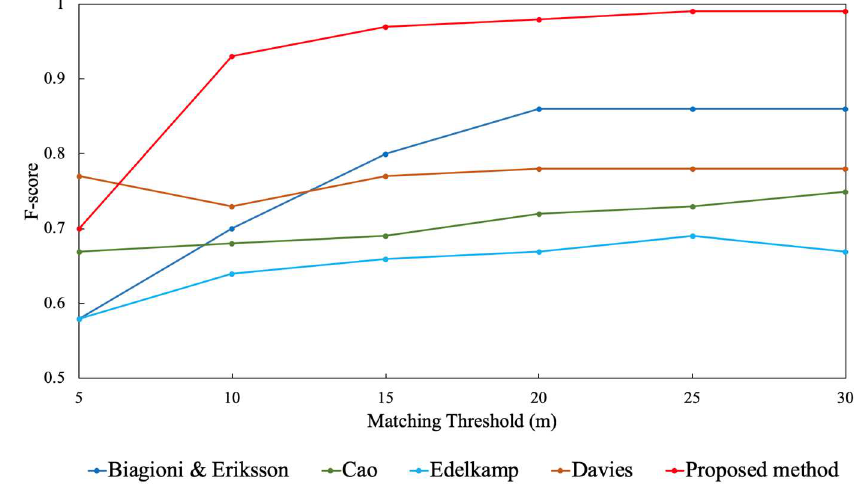
Figure 12. F - score of the proposed and existing methods. Figure 12. F − score of the proposed and existing